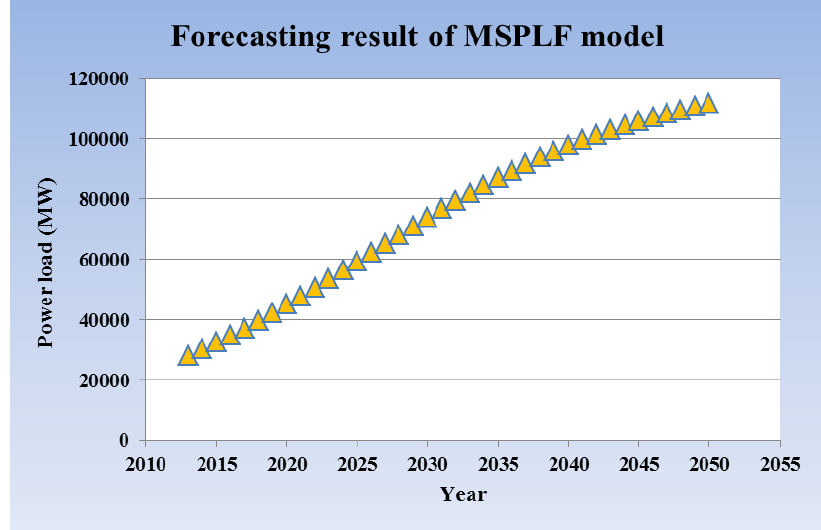
Figure 13. Forecasting result of Hubei Province’s power load from 2013 to 2050 according to the MSPLF model.